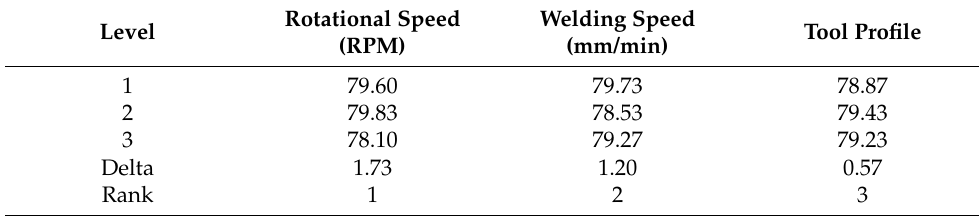
Table 6. Response table for the means of hardness in the SZ.